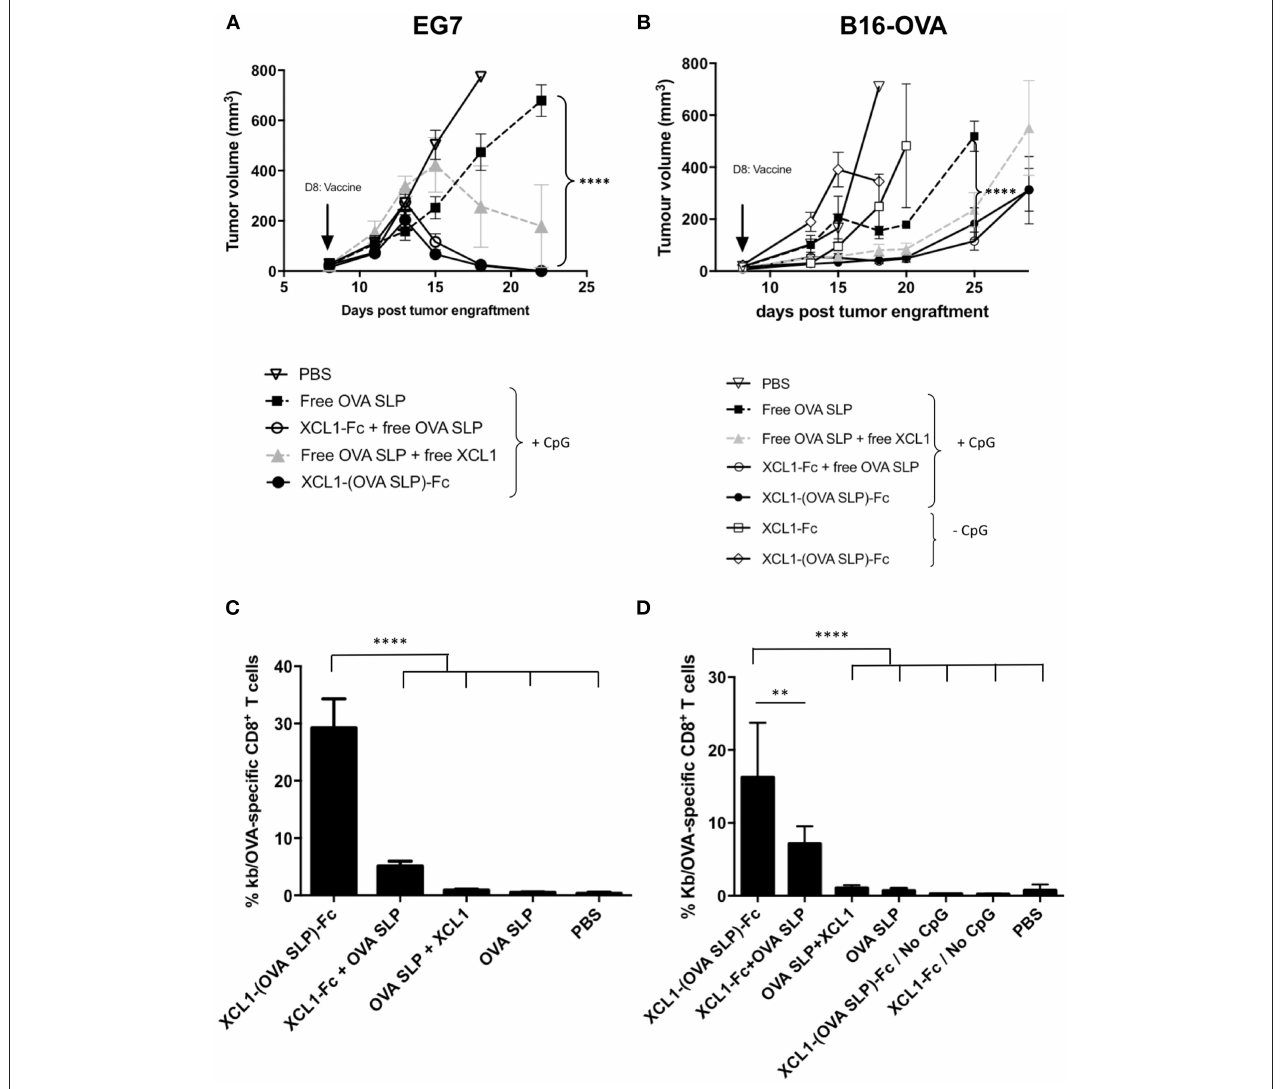
FIGURE 3 | Anti-tumor immunity upon Xcl1-(OVA SLP)-Fc therapeutic vaccinations in tumor bearing mice. (A) Tumor growth of the T lymphoma EL4-OVA cell line (EG7) grafted s.c. on the flank of mice (1 x 10 6 cells), followed on day 7 by the i.v. transfer of 10 5 OT-I cells and on day 8 by i.d. vaccination on the left foot (arrow). Cohorts of mice received equimolar amounts of Xcl1 and OVA SLP antigen as described in Materials and Methods. All cohorts received 50 µ g of CpG-ODN, except the PBS control (B) Tumor growth of B16.OVA tumors engrafted s.c. on the flank of mice (2 x 10 5 cells), followed on day 7 by the i.v. transfer of 10 5 OT-I cells and on day 8 by i.d. vaccination on the left foot (arrow), as described in (A) . Graphs represent tumor kinetic as the mean of tumor volume of 6 mice per group ± SEM. n = 6 (except in groups with only fusion protein where n = 3). Results are representative of three independent experiments. (C) Frequencies of H-2Kb/OVA tetramer positive CD8 + T cells in the blood 7 days after vaccination of EG7 and (D) of B16.OVA tumor bearing mice as described, respectively, in (A,B) . Data are shown as mean ± SEM ( n = 6 mice/group). Results are representative of two independent experiments. ** p < 0.01, **** p <